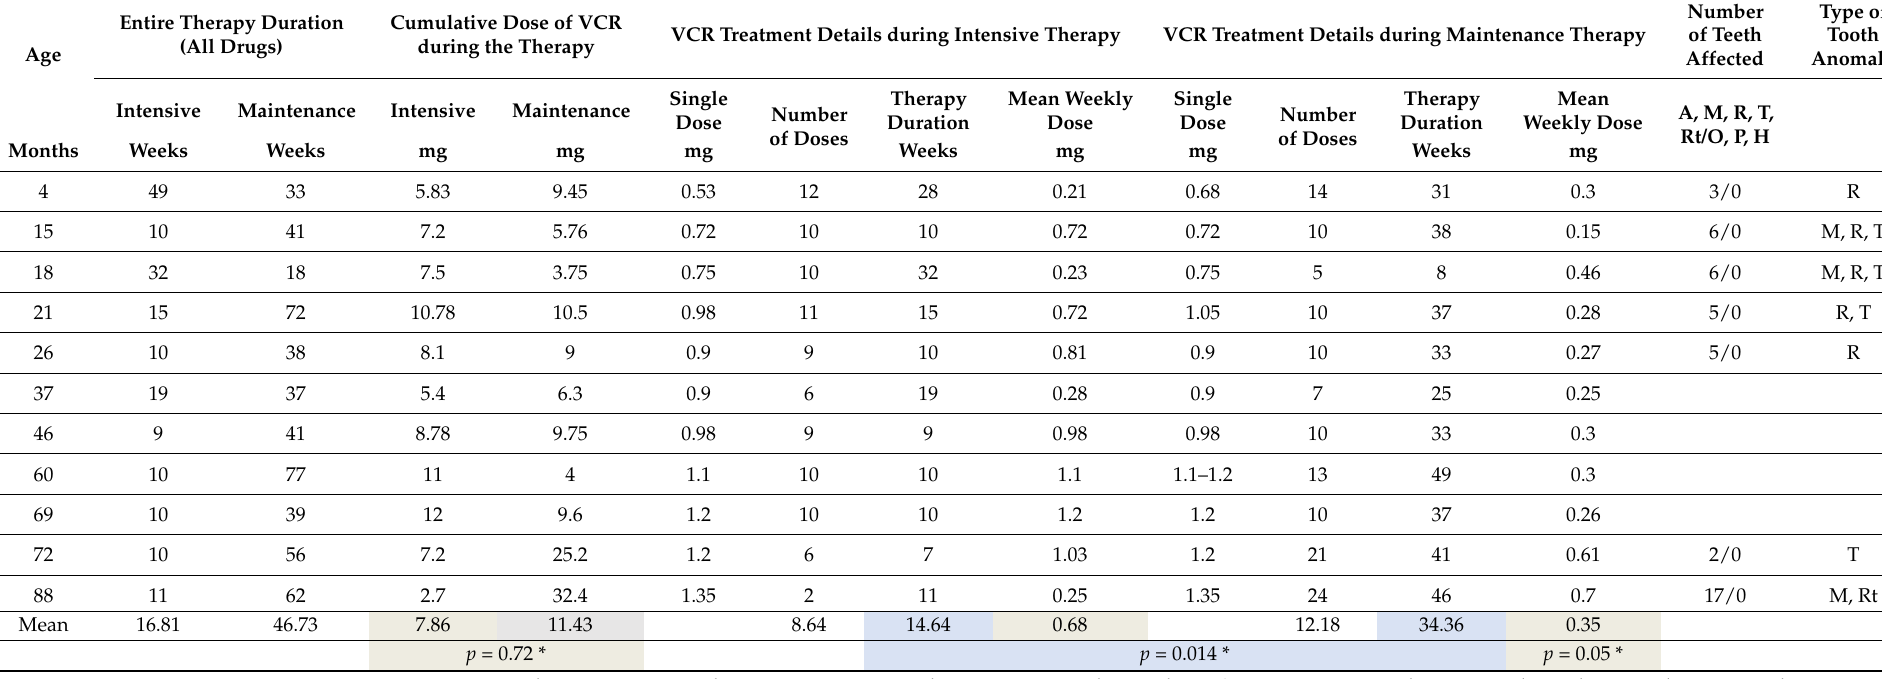
Table 3. Therapy characteristics in patients receiving VCR during intensive and maintenance treatment in relation to number of teeth affected and type of